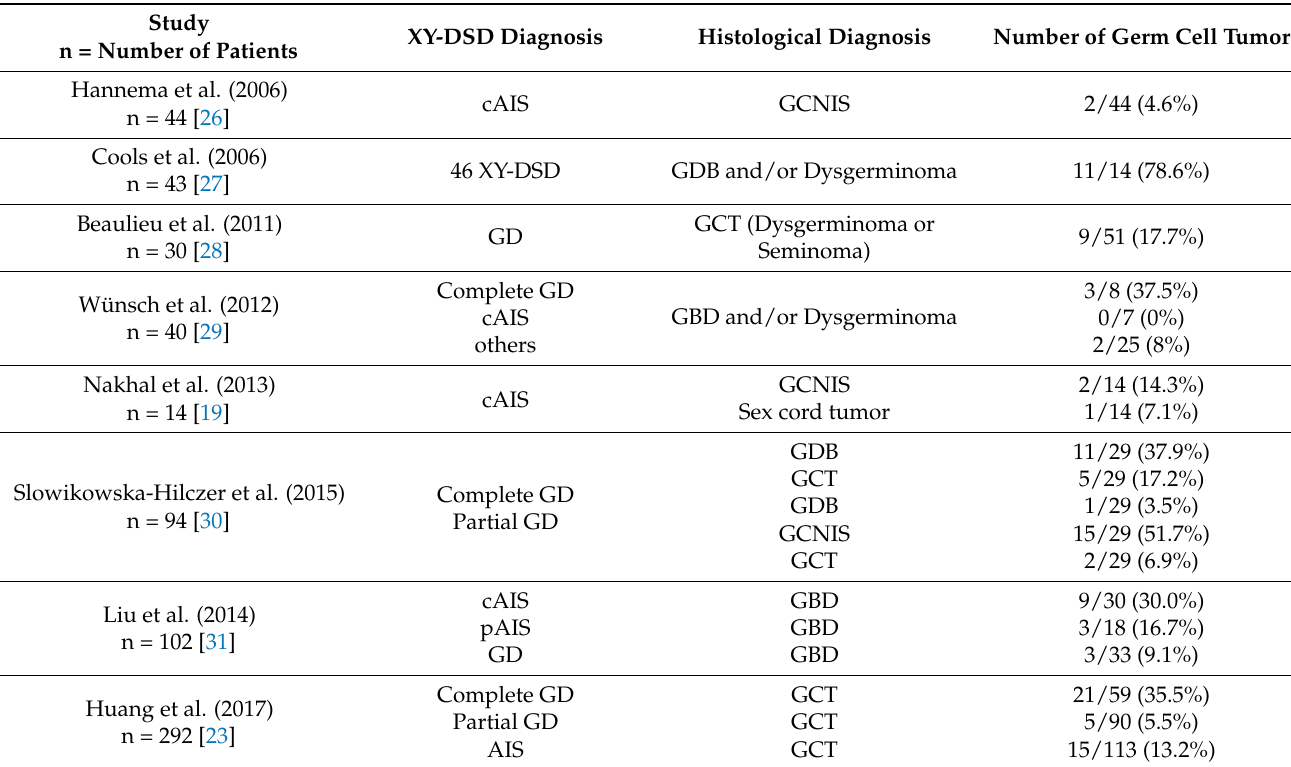
Table 2. Review of the